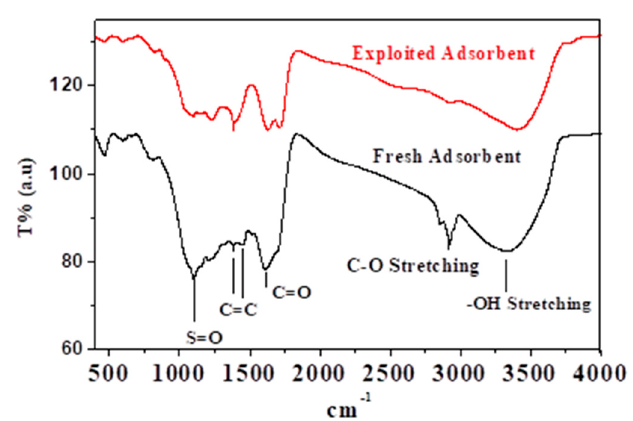
Figure 1. IR spectra of fresh and adsorbent.